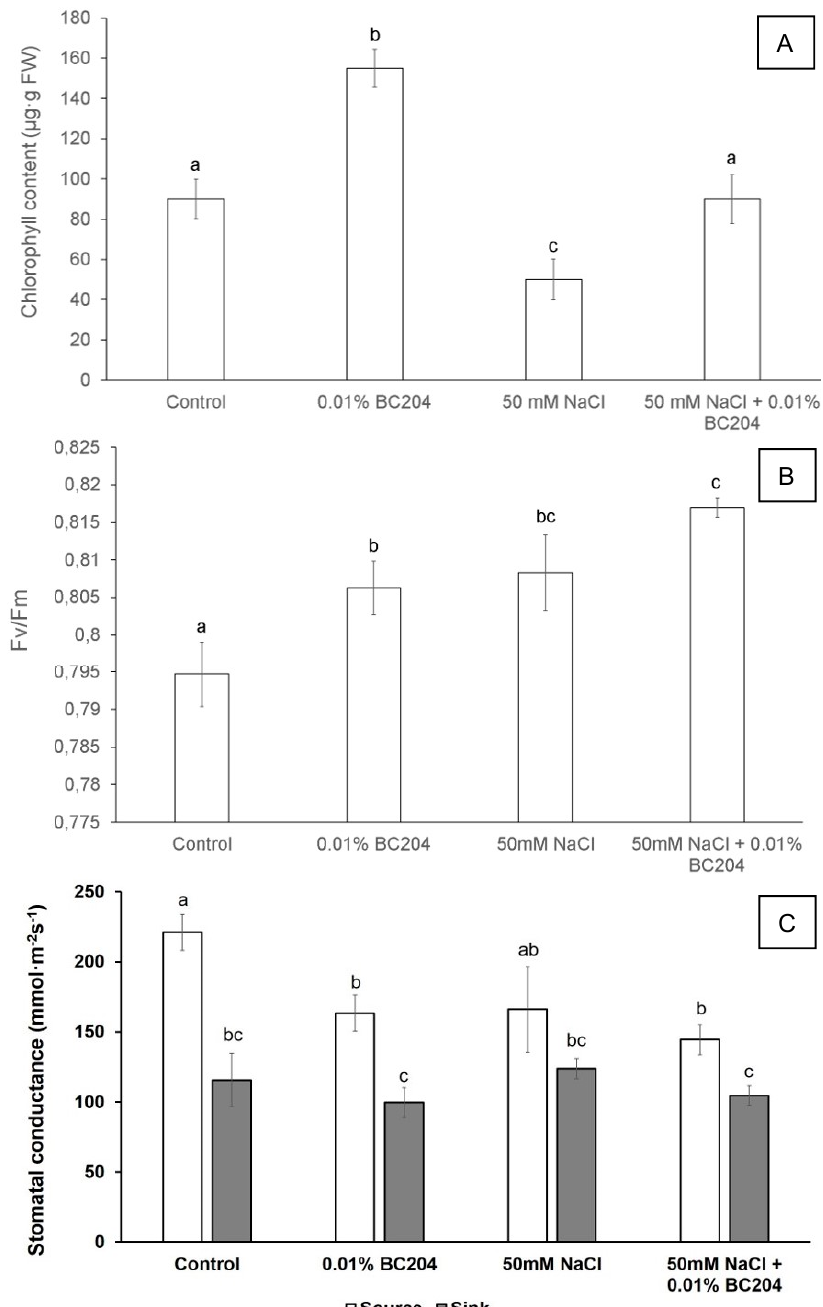
Figure 5. Total chlorophyll content ( A ), Fv / Fm ( B ) and stomatal conductance ( C ) in Arabidopsis thaliana plants subjected to NaCl-stress, BC204 treatment and a combination of BC204 and NaCl. Bars represent the mean of 9 replicates (n=9) ± standard error. Different letters indicate values that were determined by one-way ANOVA with Fisher’s LSD post-hoc test to be significantly different (P<0.05) from the control. 2.4. BC204 Attenuates the High Levels of Anthocyanin, Proline and Malondialdehyde Content Elicited